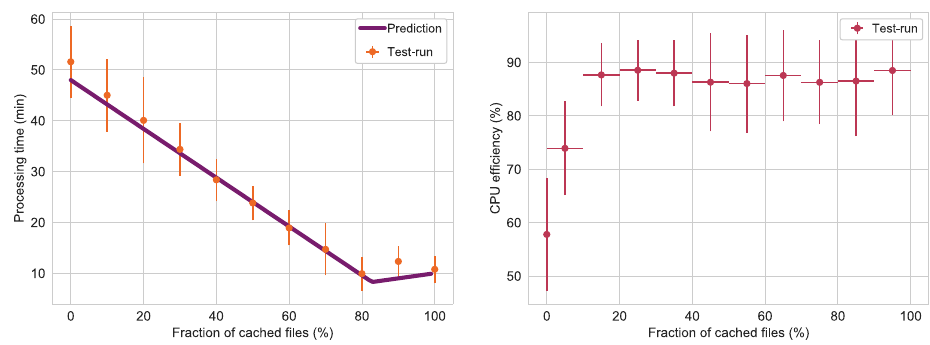
Figure 2. Performance benchmarks allow to scan for optimal working point (left), whereas a CMS jet energy calibration work-flow allows to estimate the real improvement of a typical HEP analysis. Here, data points show the mean value, error bars the corresponding standard